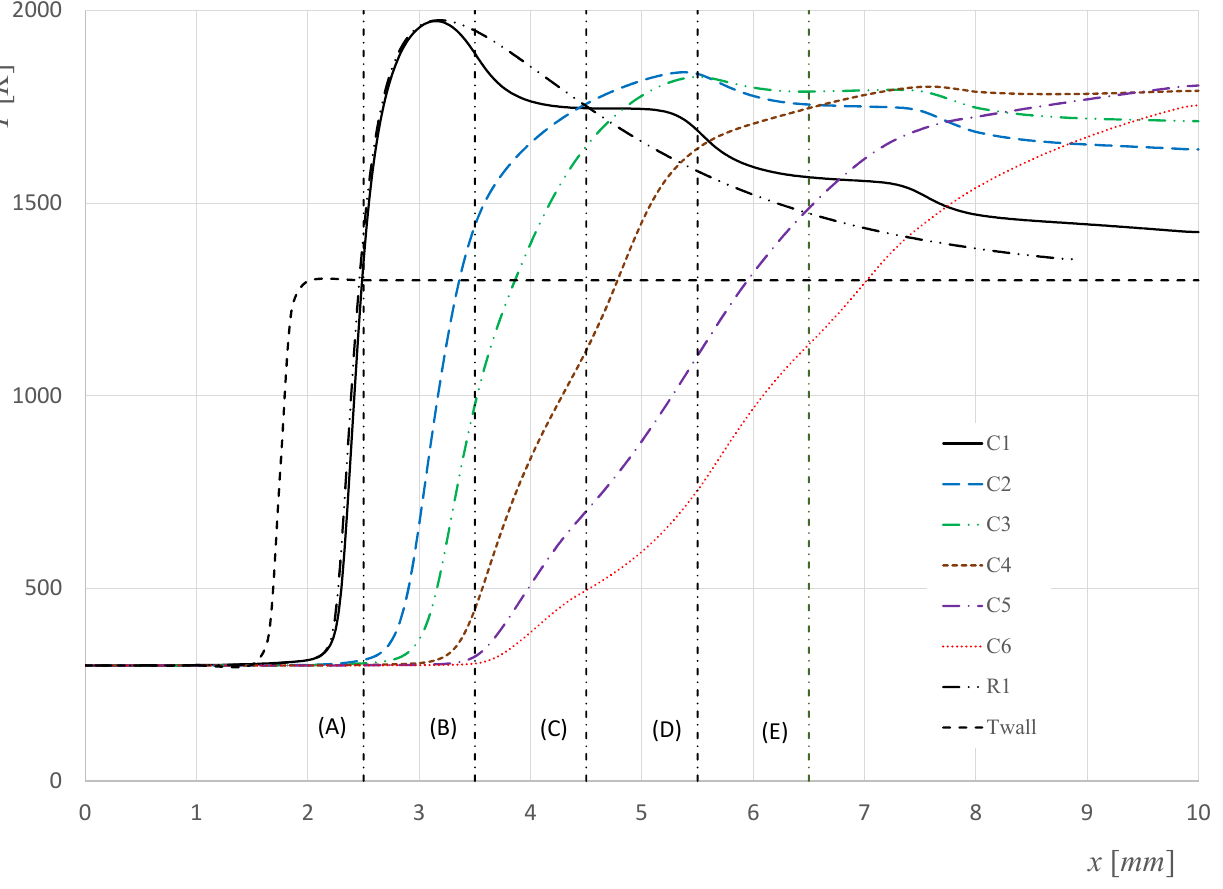
Figure 8. Temperature profiles along the centerline axis for different inlet